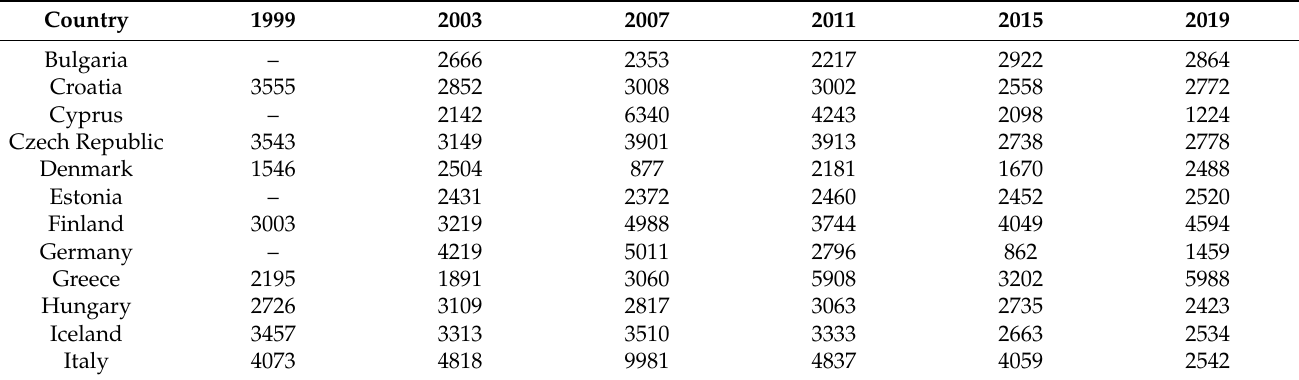
Table A1. Sample size, by country and year (1999–2019), including